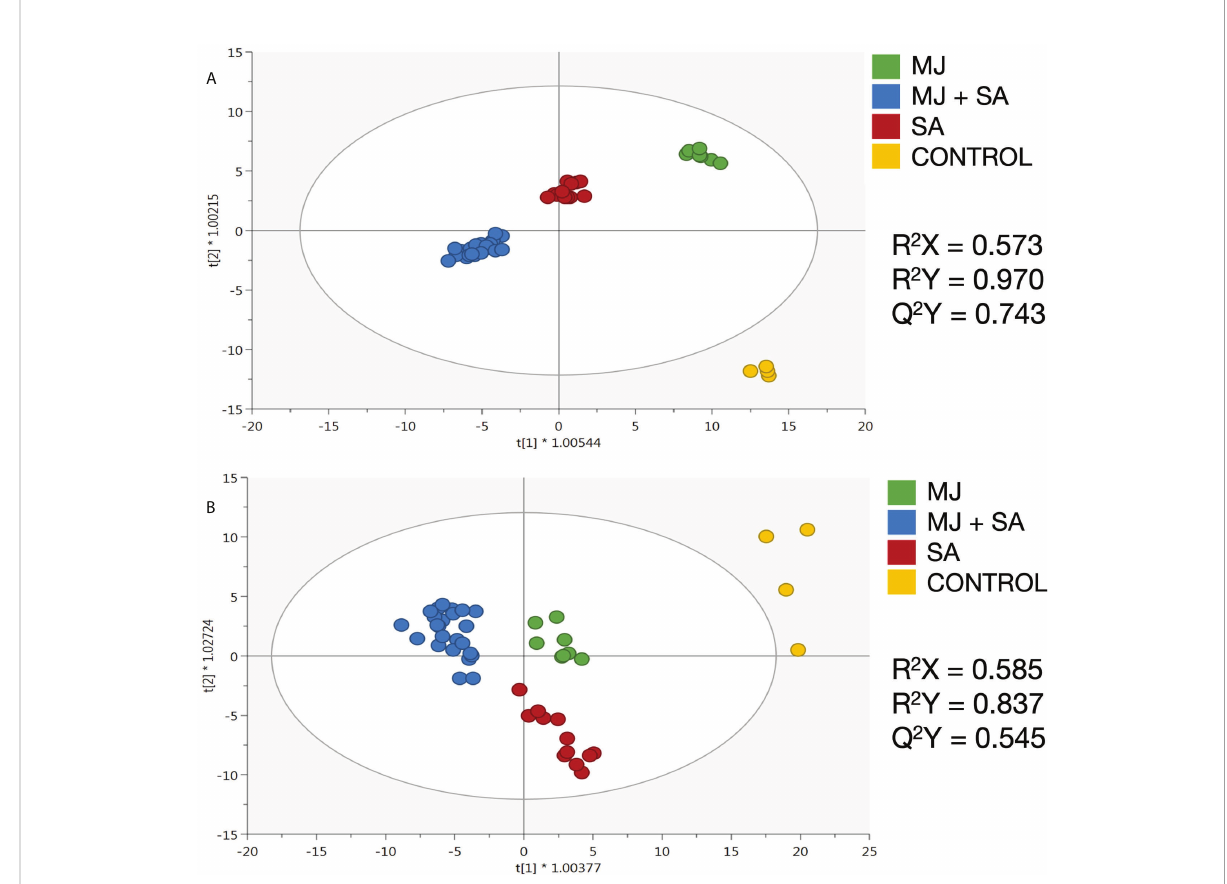
FIGURE 1 Orthogonal projection to latent structures models on the untargeted phenolic pro fi le of elicited (A) B. daigremontianum and (B) B. x houghtonii cell suspension cultures, together with their quality parameters for goodness-of- fi t (R 2 X and R 2 Y) and predictability (Q 2 Y). MJ, methyl jasmonate; SA, salicylic